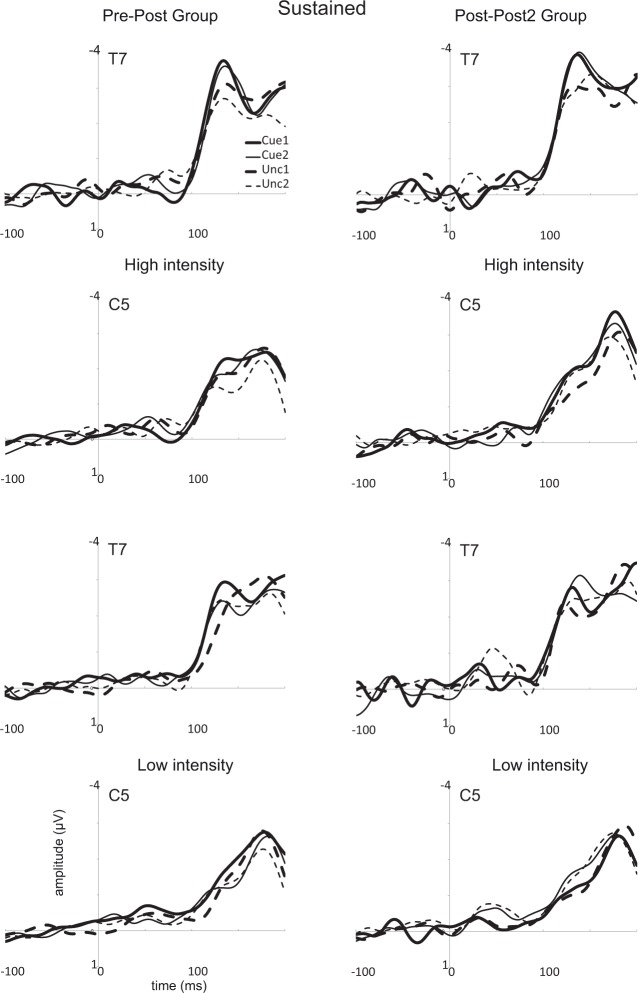
Event-related potentials (ERPs) evoked by the intracutaneous electrical stimuli over contralateral sites (T7 and C5) in the sustained spatial attention conditions.Averages are shown for cued stimuli in the first and the second session (Cue1 and Cue2) and for uncued stimuli in both sessions (Unc1 and Unc2). Results for high intensity stimuli are displayed in the two upper rows while results for the low intensity stimuli are presented in the two lower rows. Results for the pre-post group are presented in the left panel, while results for the post-post2 group are presented in the right panel.